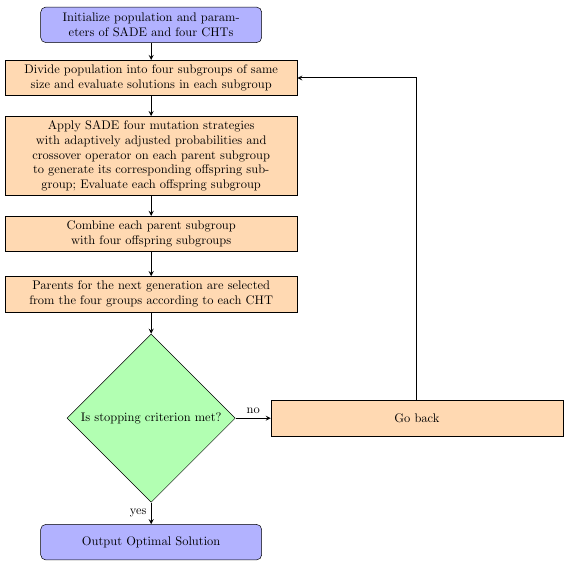
Figure 2. Flowchart of